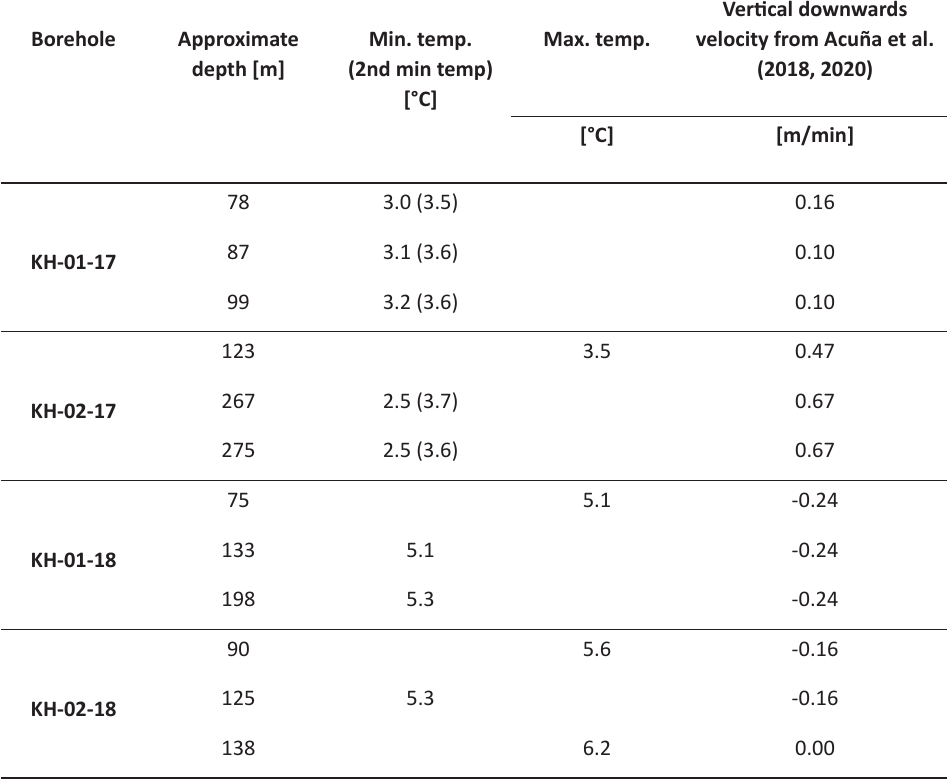
Table 2. Temperatures and vertical groundwater flow values used in the estimation of fracture groundwater flow: Temperature is abbreviated “temp.” Minimum is abbreviated “min.” and maximum is abbreviated “max.” The second lowest temperature is denoted “2nd min